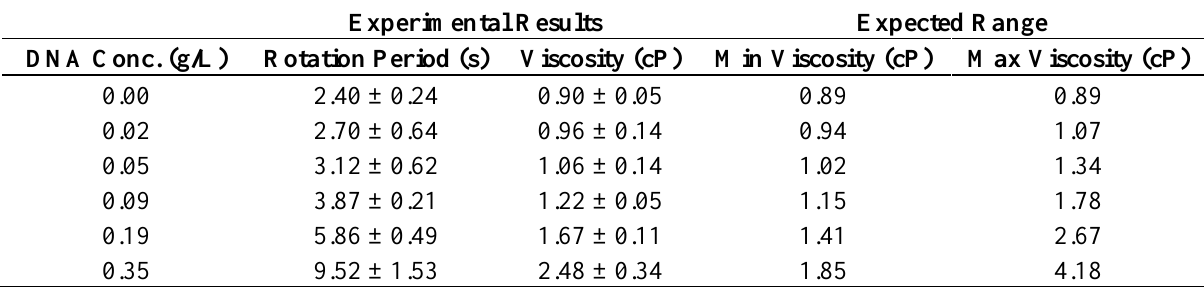
Table 1. Rotation periods and viscosities of lambda DNA Eco RI digest solutions at different DNA concentrations measured by AMBR microviscometer. The expected ranges of viscosities are calculated, assuming only the longest or shortest piece of DNA is